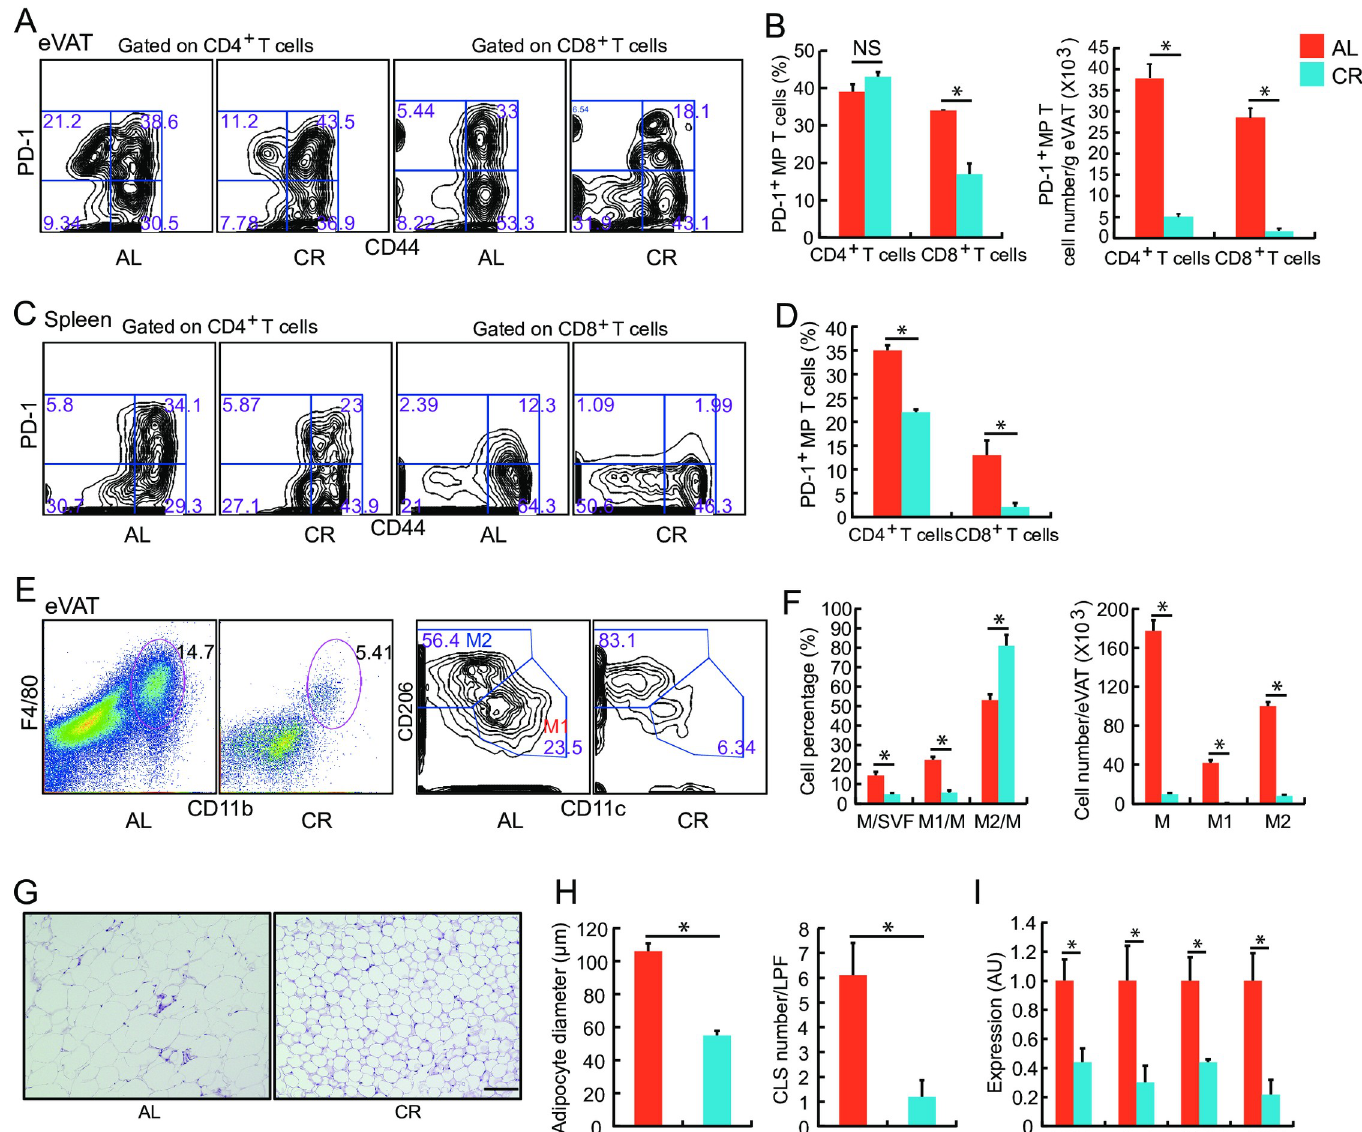
Fig 5. Effects of caloric restriction (CR) on the PD-1 + T-cell subpopulation and adipose inflammation in aged mice. Fifty-two-week-old mice were fed either ad libitum (AL) or treated with caloric restriction (CR) and analyzed on reaching 80 weeks of age. ( A, B ) Flow cytometric analysis of PD-1 + CD44 + T cells (PD-1 + MP T cells) in SVF from eVAT of the AL and CR mice. ( C, D ) Flow cytometric analysis of PD-1 + CD44 + T cells (PD-1 + MP T cells) was performed using spleen cells of the AL and CR mice. ( E, F ) Flow cytometric analysis of M1 type macrophages (CD11b + F4/80 + CD11c + CD206 - ) and M2 type macrophages (CD11b + F4/80 + CD11c - CD206 + ) in the eVAT of AL and CR mice. ( G ) Representative images of H&E staining of eVAT from AL and CR mice. Scale bar, 100 μ m. ( H ) Mean adipocyte diameter and the number of crown-like structures (CLS) in eVAT were determined. ( I ) Real-time PCR analysis of cytokine expression in eVAT. The expression levels of each transcript were normalized to those in the mice fed AL ( n = 7–9 mice in each group). � P < 0.05; NS: not significant. Data are represented as the mean ± SEM. SVF; stromal vascular fraction, TNF- α ; tumor necrosis factor- α , IL-6; interleukin-6, CCL2; chemokine ligand 2, OPN; osteopontin. AU: arbitrary